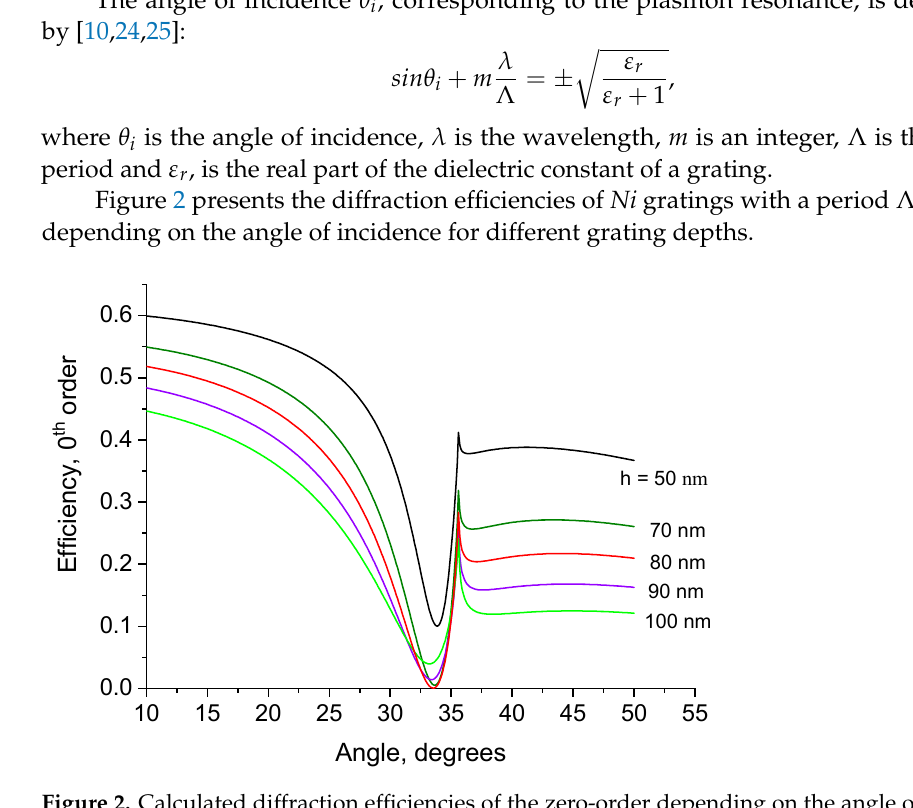
Figure 2. Calculated diffraction efficiencies of the zero-order depending on the angle of incidence for the nickel grating with a period Λ = 400 nm and different depths h = 50, 70, 80, 90, 100 nm at a wavelength of radiation λ = 632.8 nm with p -polarization.